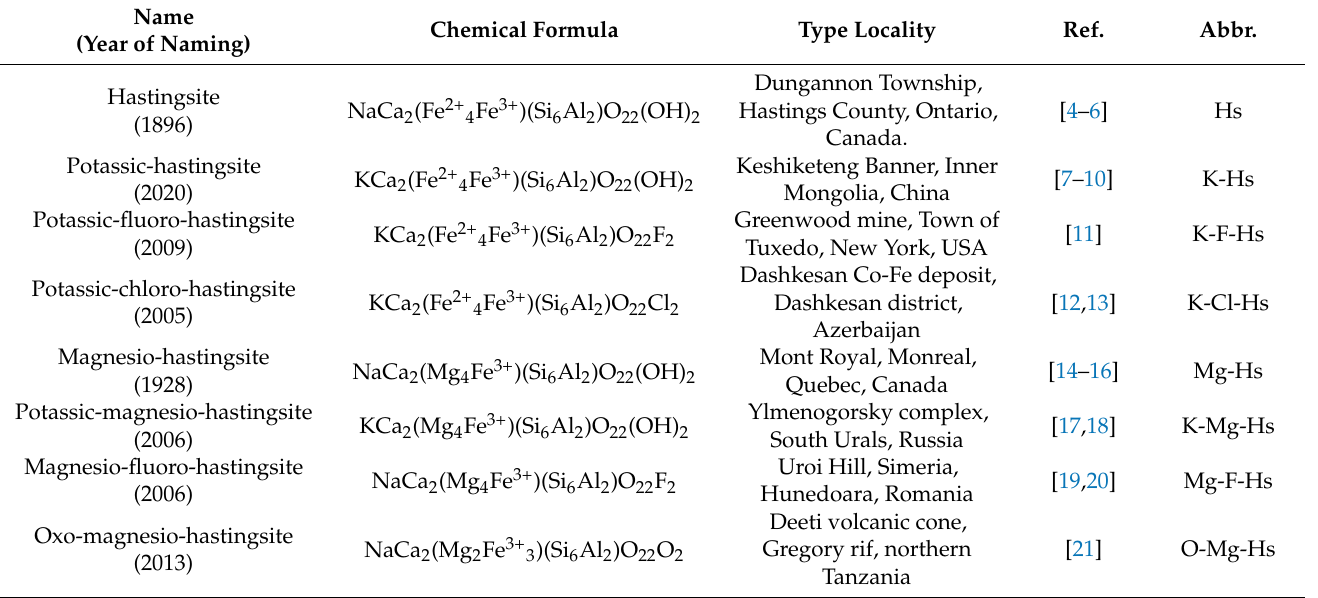
Table 1. Previously published selected data on